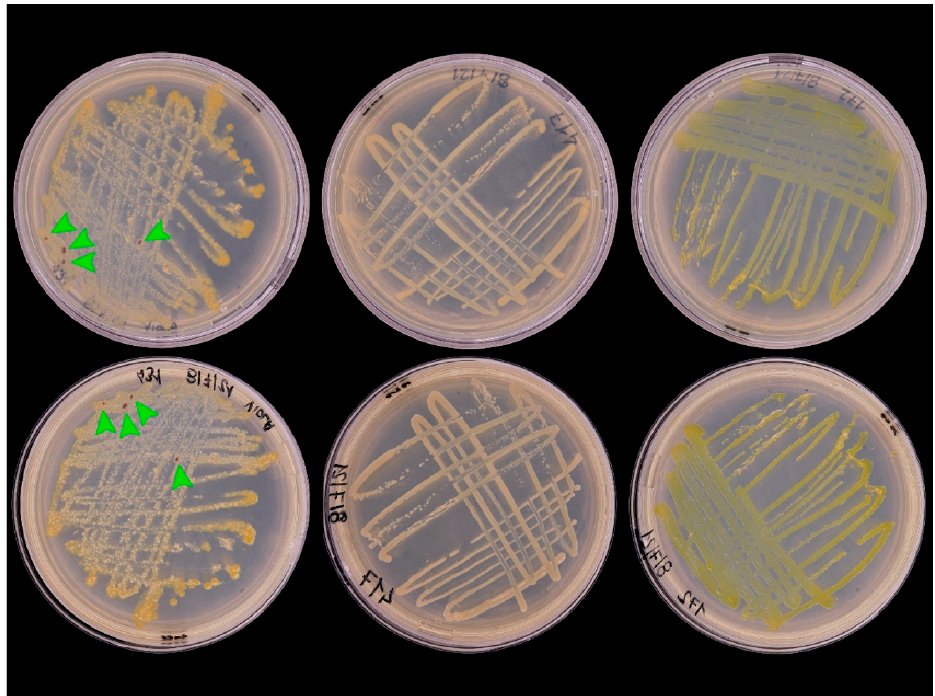
Figure 3. Bacterial isolates in Petri dishes from JAF, identified as genera (from left to right): Pseudomonas , Agrobacterium , Microbacterium ; upper and lower Petri sides; green arrows indicate purple spots of the genus Pseudomonas .